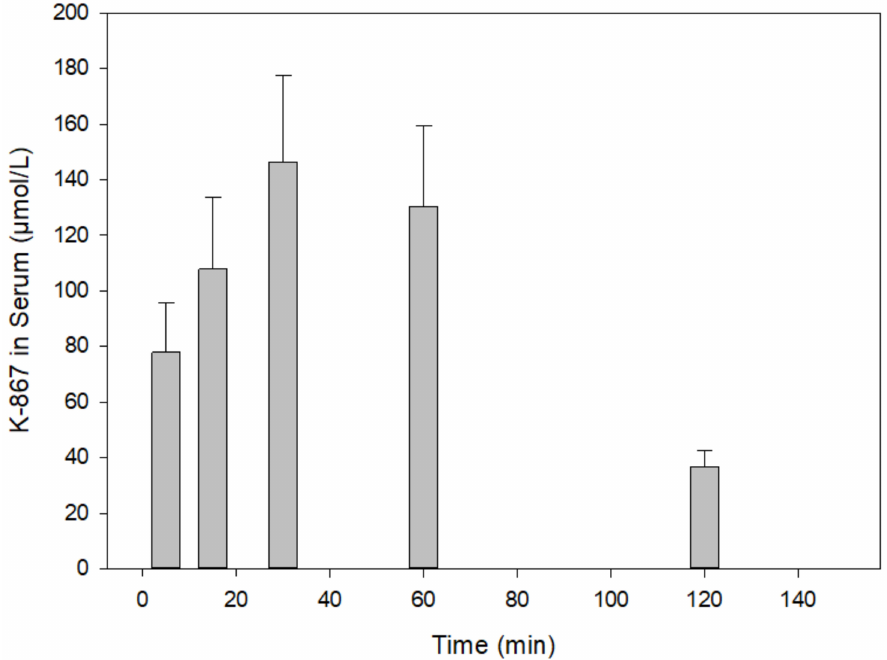
Figure 5. Time course of K-867 content in serum following its intramuscular administration of 30 µ mol. The results show the means and standard deviations obtained in 4 parallel treatments. The displayed concentrations are the means of 5 HPLC determinations